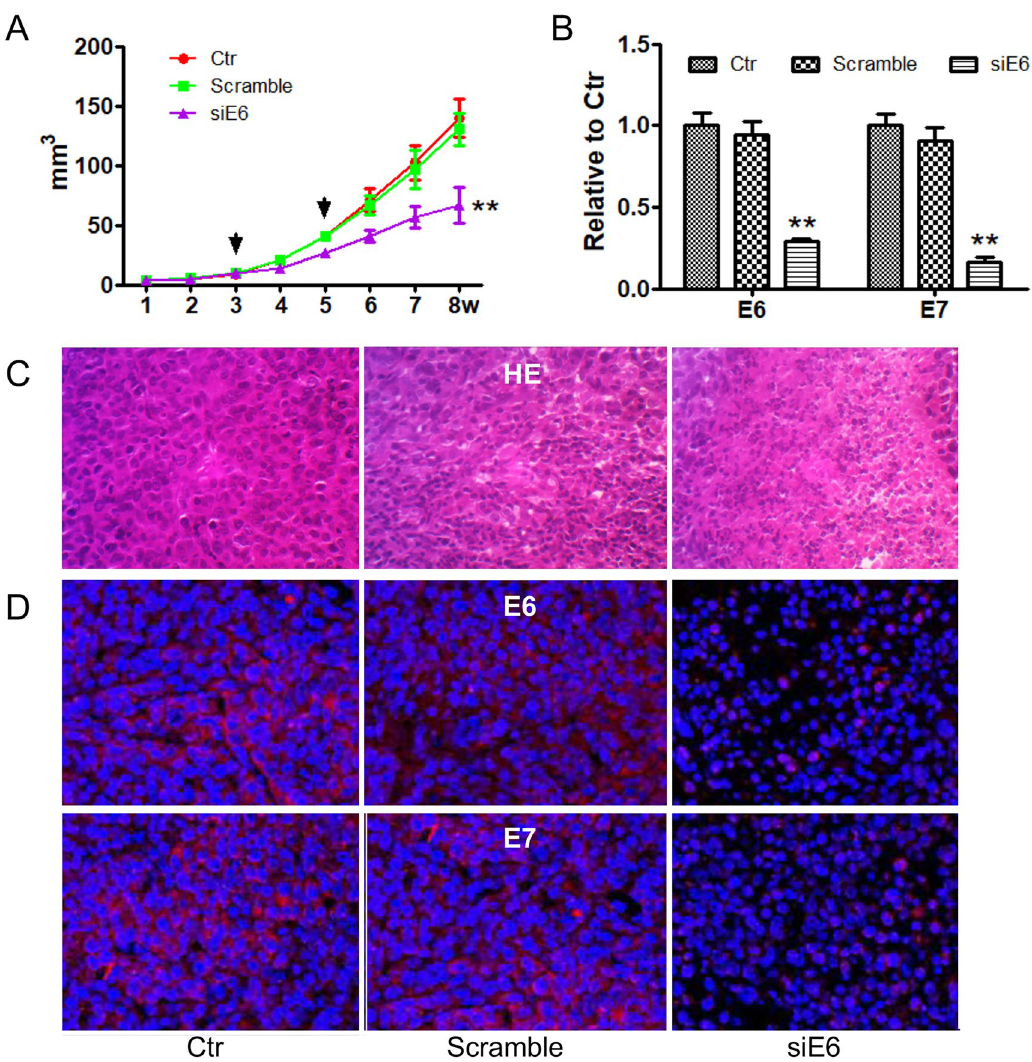
Figure 5. pCG-siE6 can inhibit the growth of the xenograft tumors in vivo. ( A ) Growth of Siha xenografts treated with pGC-siE6 (n = 5). Each treatment with the plasmid is shown an arrow. **P < 0.01, vs the two control groups. ( B ) Semi-quantitative RT-PCR analysis of HPV16-E6/E7 mRNA in Siha xenografts treated with pGC- siE6 plasmids. **P < 0.01, vs the two control groups. ( C ) HE assay for Siha xenografts treated with pGC-siE6 plasmids (× 400). ( D ) Fluorescence immunohistochemical analysis of HPV16-E6/E7 protein expression in Siha xenografts treated with plasmids (×